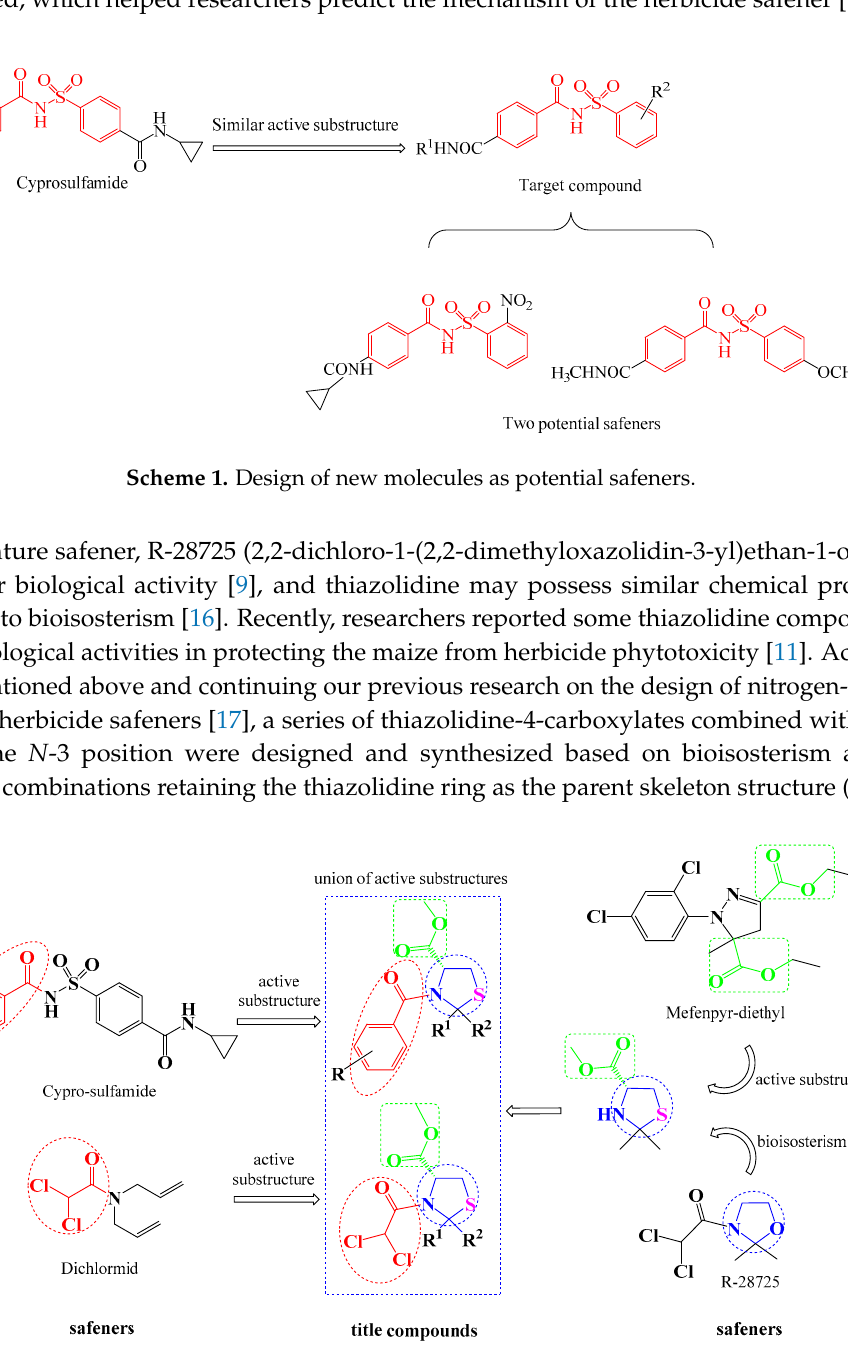
Scheme 2. Design of the title compounds.